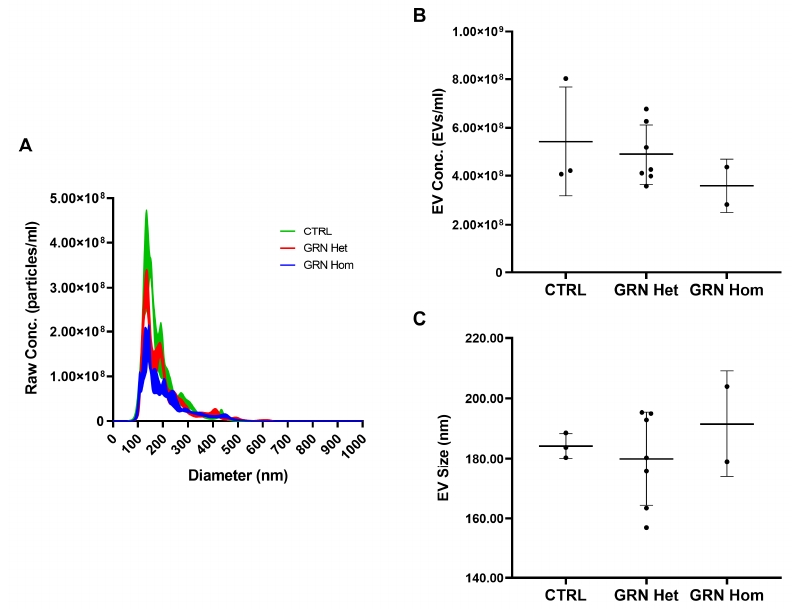
Figure 3. EV concentrations and sizes in LCLs from WT controls and heterozygous and homozygous GRN mutation carriers. ( A ) Representative spectra from NTA of CTRL (green), GRN Het (red), and GRN Hom (blue) EVs isolated from LCL-conditioned media. ( B ) EV concentration (EVs/mL) and ( C ) EV size (nm) in LCL-conditioned media from WT controls and GRN mutation carriers. Graphs represent mean ± SD. Statistical analysis by one-way ANOVA with Bonferroni post-hoc tests. Het = heterozygous; Hom =